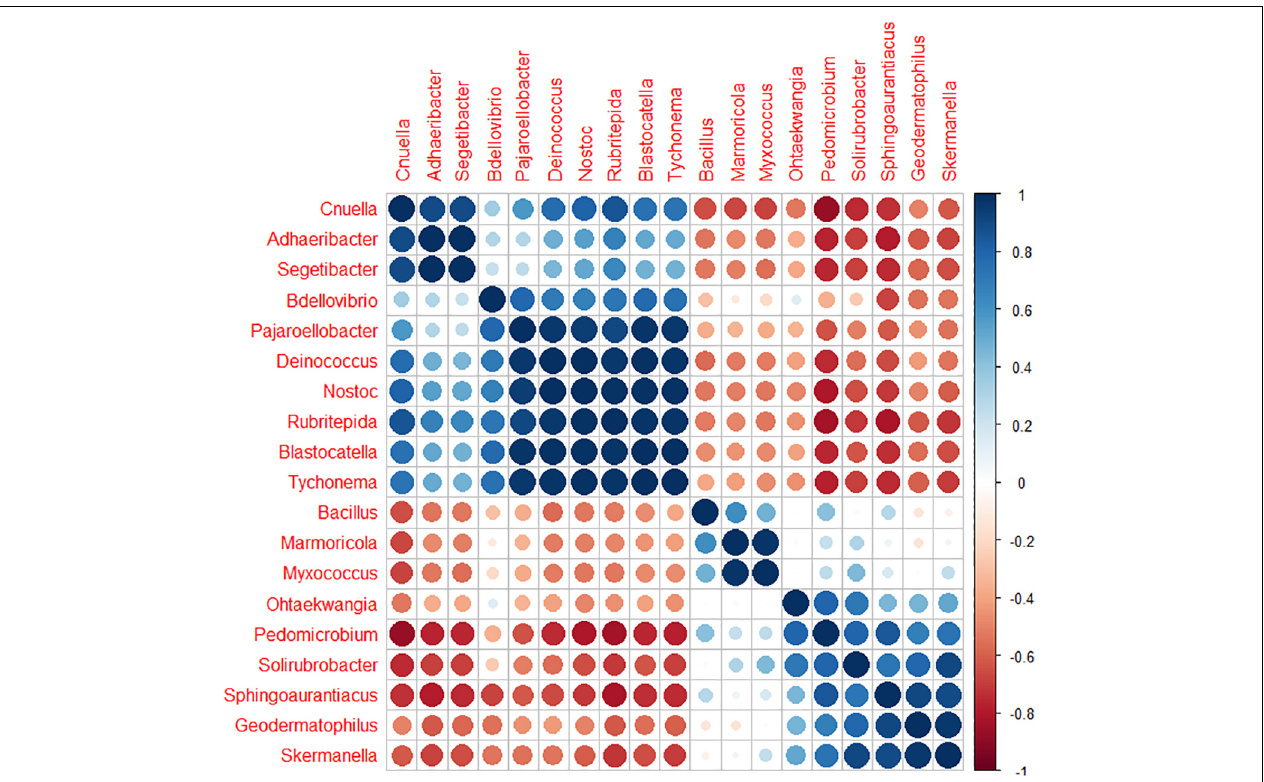
FIGURE 6 | Correlogram representing the Pearson’s correlation coefficient r 2 between the 19 key bacterial genera ordered by the “hclust”